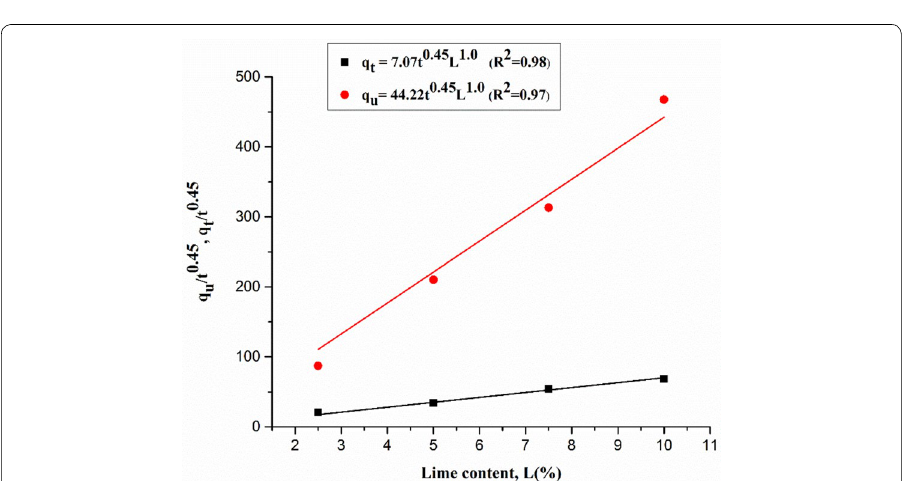
Fig. 8 Relationship between unconfined compressive strength (q u ) and split tensile strength (q t ) with various lime content (L), and curing period